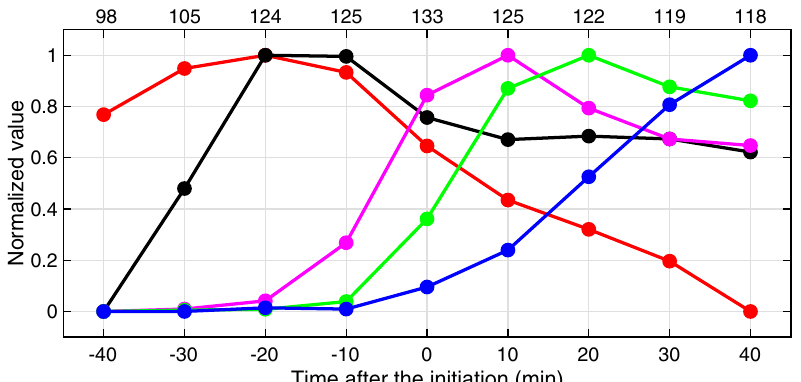
Fig. 5 Evolution of normalized averages of simulated parameters, over 133 rainy locations (in radius of ~5 km). The red, black, magenta, green, and blue lines indicate the results for convergence, total cloud water path (liquid and ice), rain water content at the cloud base height, surface rain rate, and divergence, respectively. The number of analyzed events at each time (marked at the top X -axis) is not constant because events that could not be tracked properly were excluded from the analysis at each